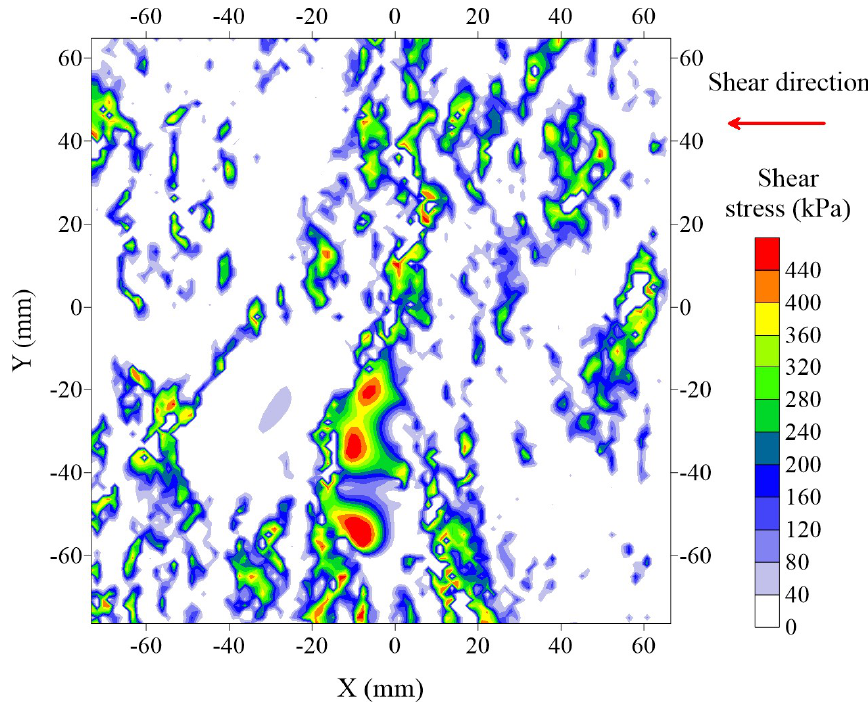
Figure 16. Shear stress distribution for shearing in the negative direction of the x